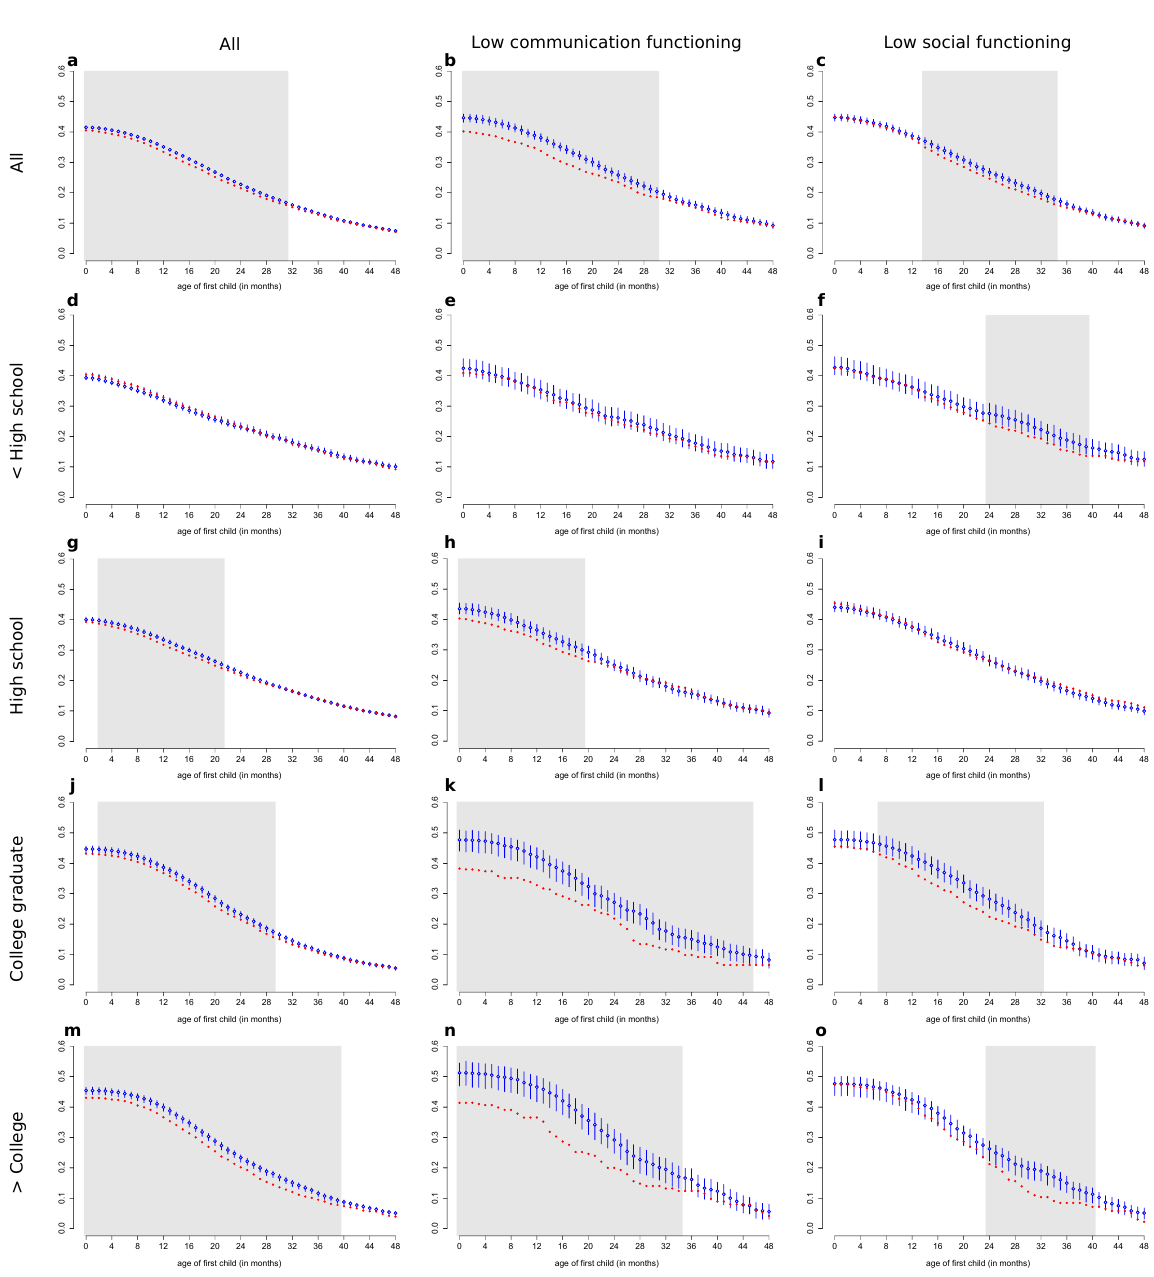
Figure 3: Proportion of mothers of firstborn children with (solid red circles) and without (open blue circles) autism who conceived a subsequent child at each given age of the first child, relative to those who have yet to conceive a second child, stratified by severity group and maternal education at first birth. Shaded areas indicate significant effects of the first child’s autism status on subsequent fertility.